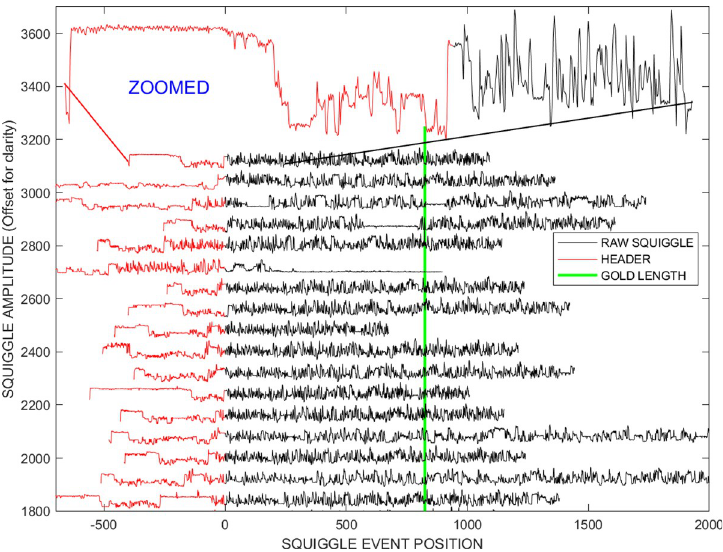
Fig 1. Identified leaders in the Sequin R2-55-3 study are shown in red. There are visually obvious internal distortions in the mainstream body, black, due to factors such as in-silico chimeric reads and mis-segmented increased pore dwell times. Identification and removal of very localized errors at the individual k-mer group level is not straight forward because of the high level of information entropy in the signal, see zoomed black section. Ideally there is